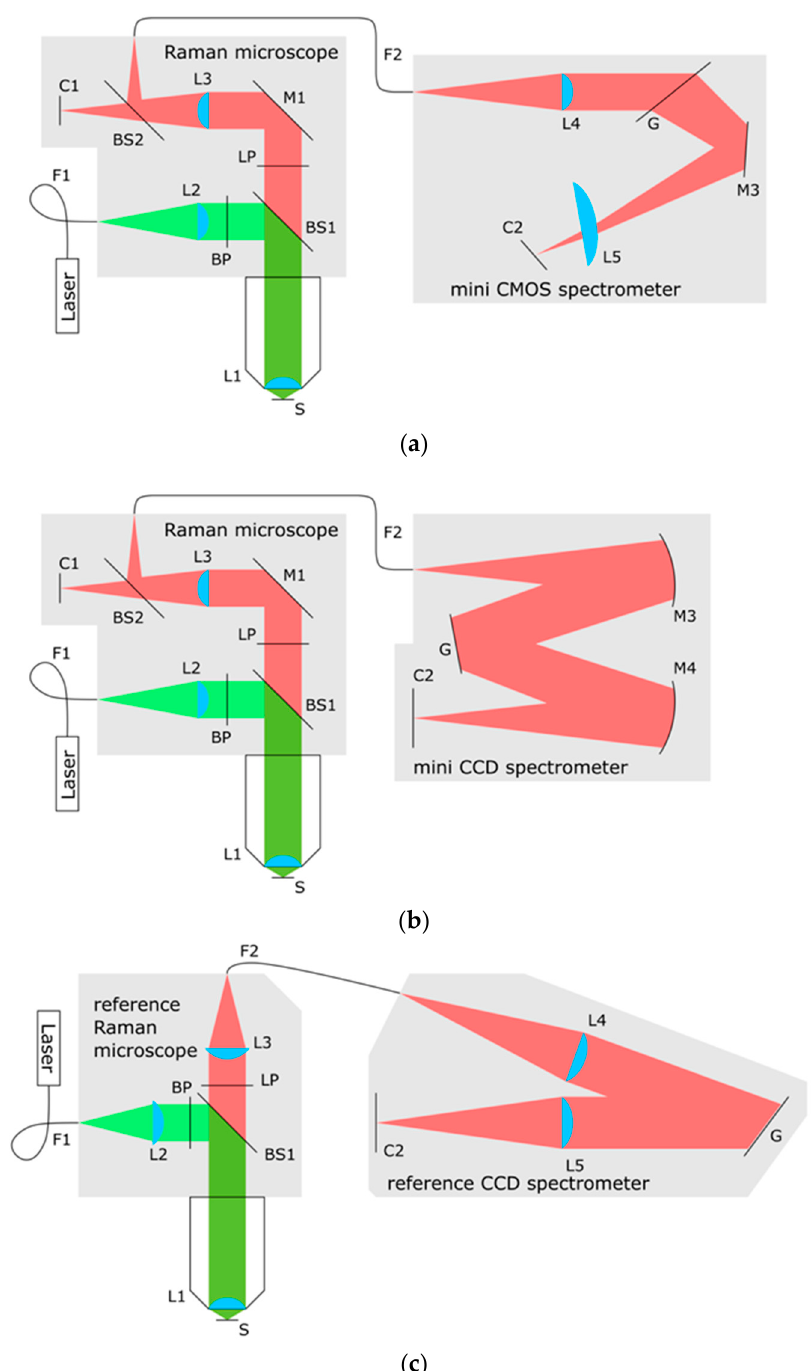
Scheme 1. Schematic optical diagram of: ( a ) the mini CMOS Raman spectrometer consisting of Raman microscope, mini CMOS spectrometer and 532 nm laser, ( b ) the mini CCD Raman spectrometer using the same microscope components and laser as (a) but a mini CCD spectrometer, ( c ) the reference Raman